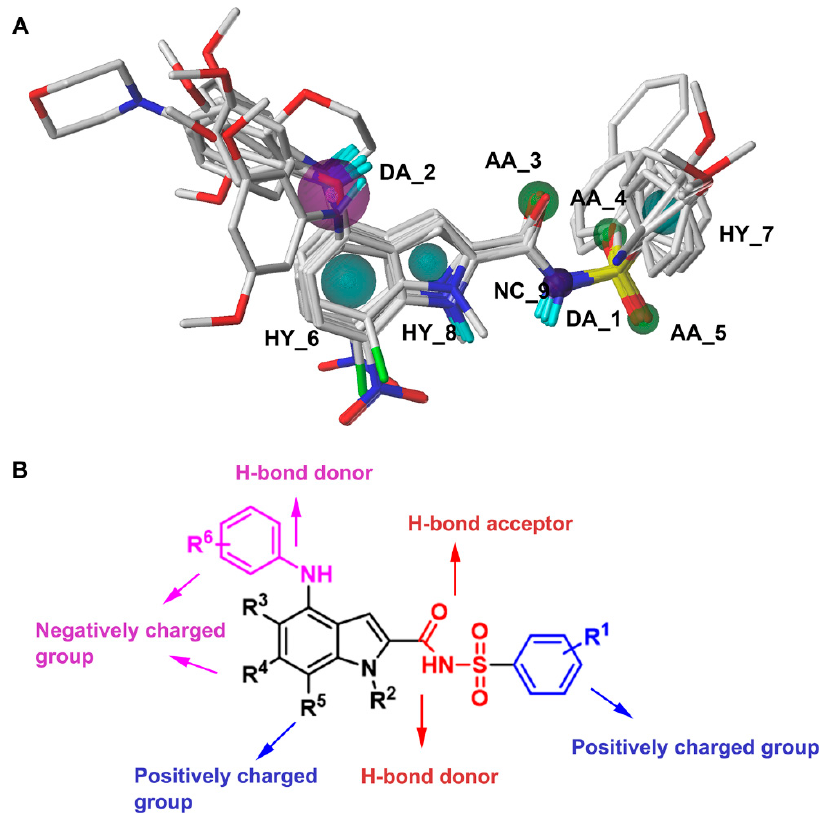
Figure 4. The constructed pharmacophore model ( A ) and the summarized SAR ( B ) of N -aryl- sulfonyl-indole-2-carboxamide derivatives as FBPIs. indole-2-carboxamide derivatives as